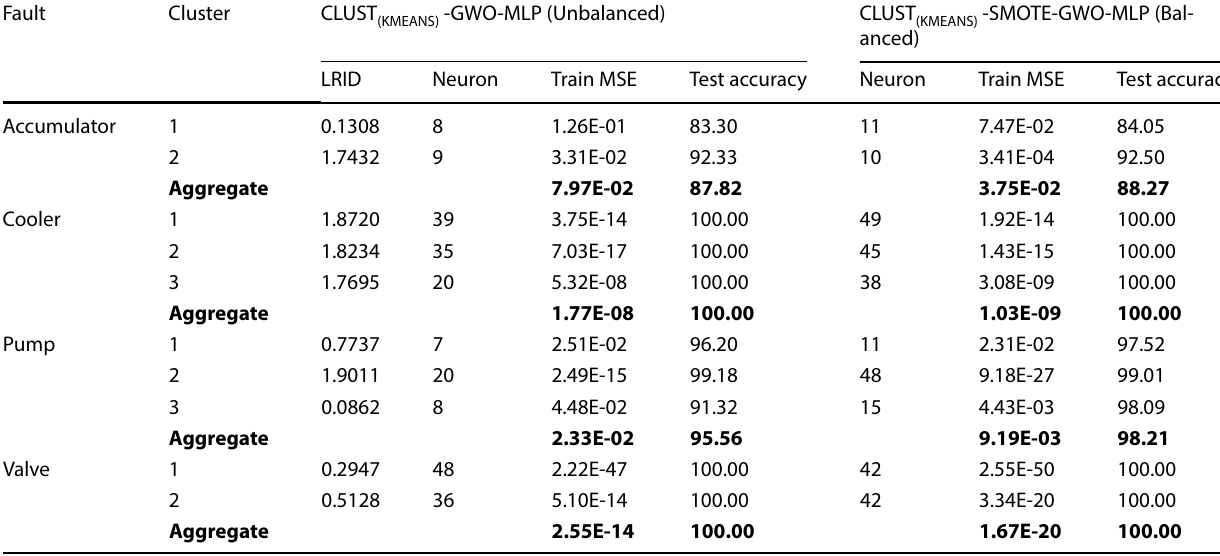
-GWO-MLP and CLUST (KMEANS)